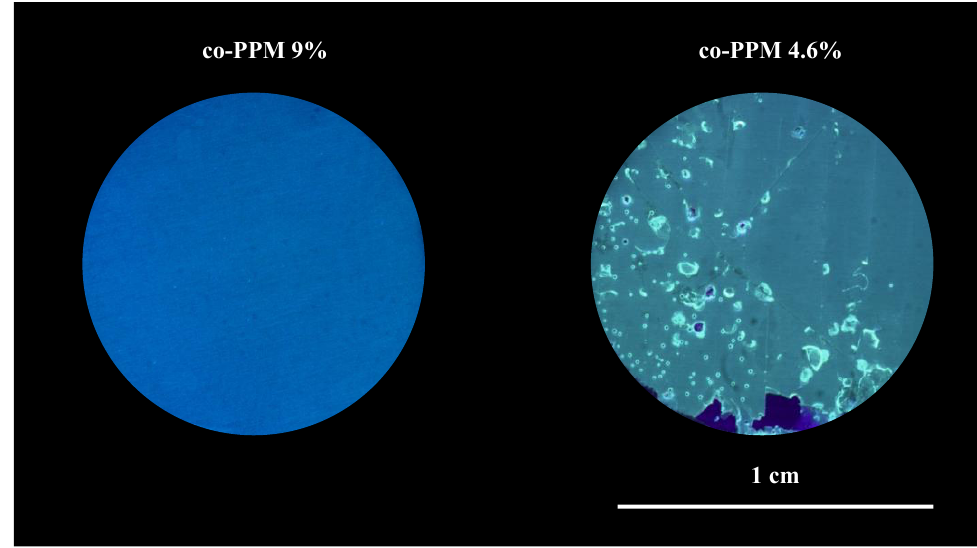
Figure 2. Optical microscope images (under 386 nm UV light) of the surface of 30 μm PPM copolymer coatings after the anodic potentiodynamic polarization. From ( left ) to ( right ): co-PPM 9% and co-PPM 4.6%.